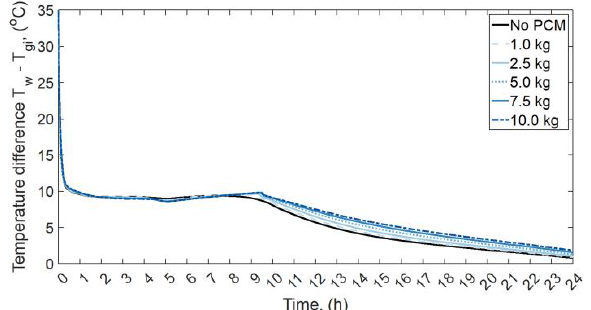
Figure 15. The temperature difference between water and inner glass cover in the SS with different masses of PCM — Case 2.